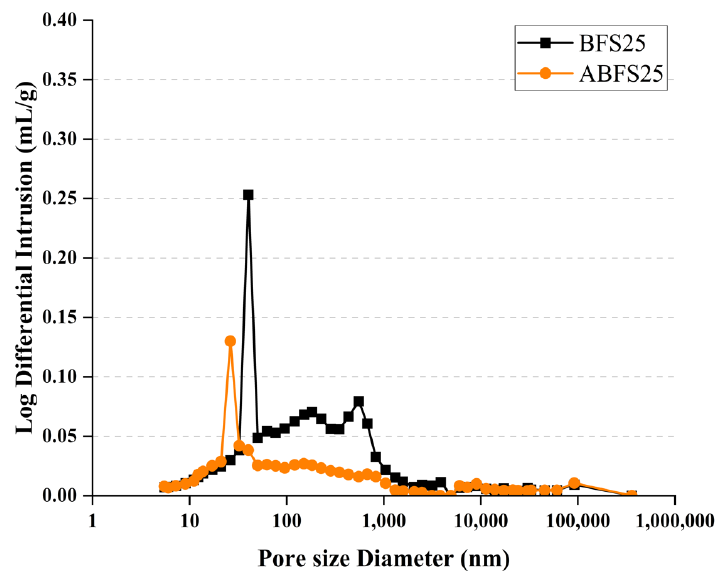
Figure 15. MIP results for BFS25 and ABFS25.